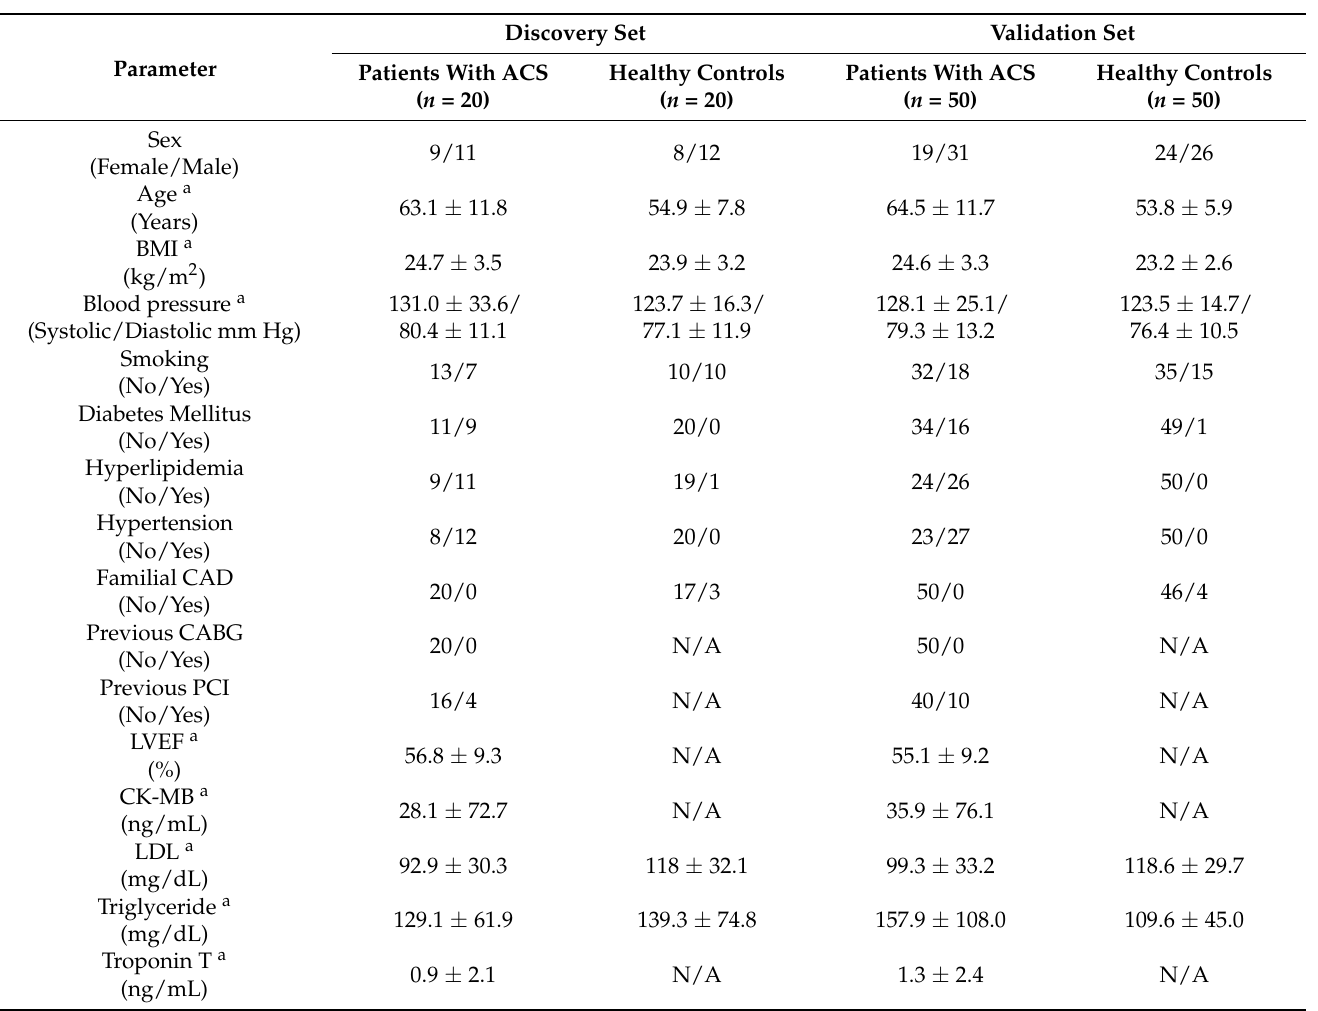
Table 3. Demographic information of